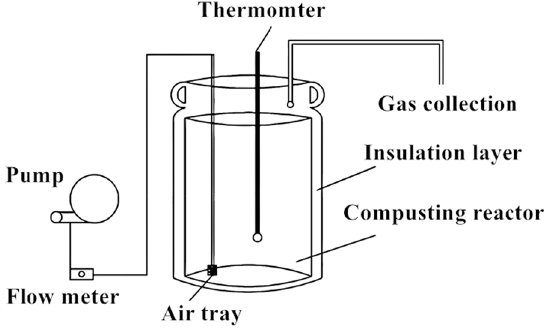
Fig. 2 The diagram of the composting